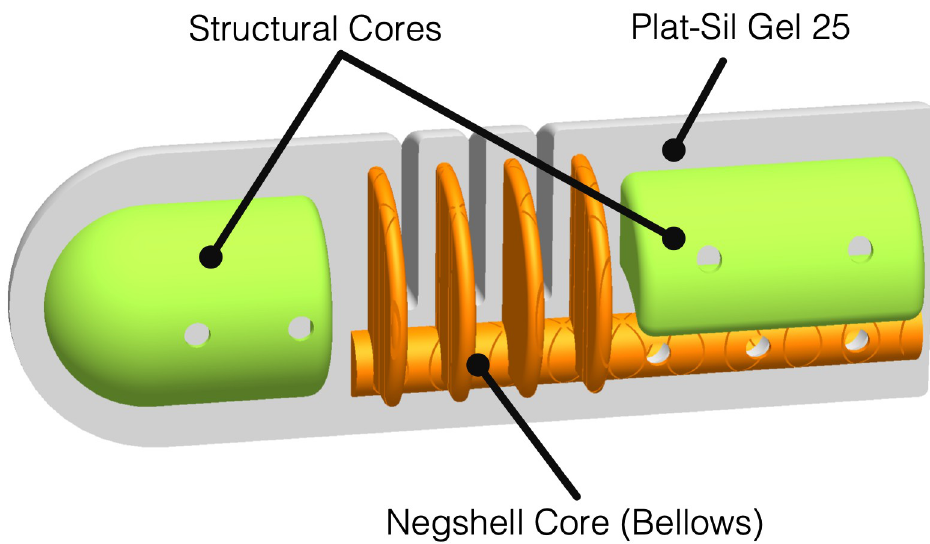
Fig 5. Cross-section of soft robotic finger. A 3D CAD model of the soft robotic finger is cut longitudinally to show the locations of the non-sacrifical cores and the negshell core that create the bellow.